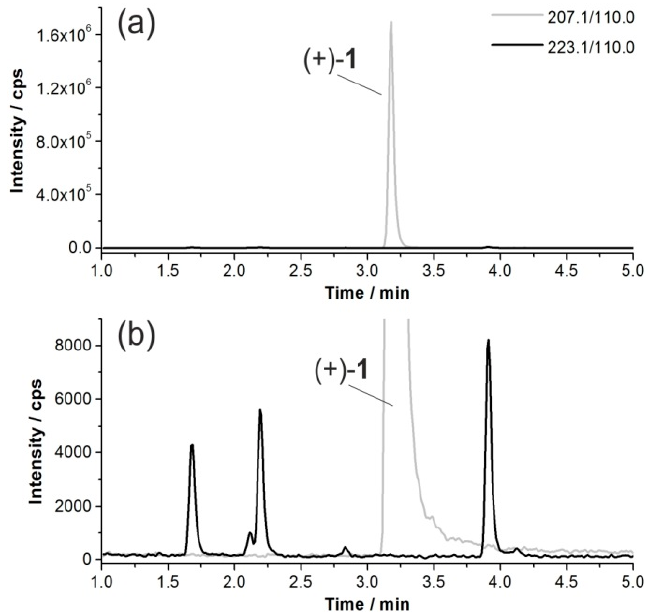
Figure 3. ( a ) Multiple reaction monitoring (MRM) chromatograms of an acetonitrile extract after incubation of (+)- 1 with mouse liver microsomes (MLM) (37 °C, 90 min), where ion traces represent unconverted (+)- 1 ( m / z 207.1 [M parent + H] + , t R = 3.2 min) and hydroxylated products ( m / z 223.1 [M parent + O + H] + ) according to the MRM transitions indicated; and ( b ) enlarged detail of ( a ).